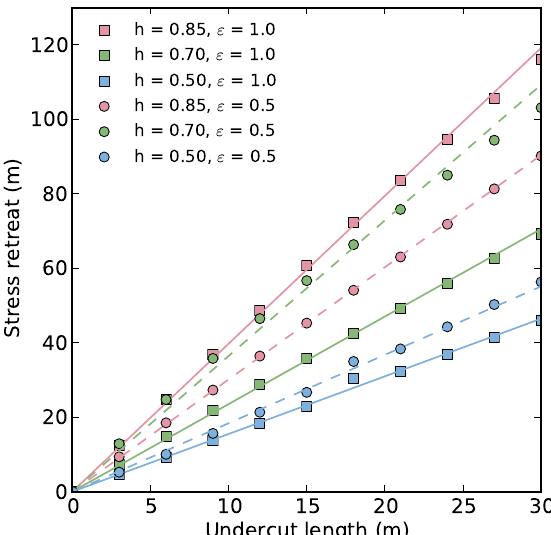
Fig. 3. Stress retreat as a function of undercut length for a variety of scenarios involving different water depths h and dry calving lengths ε . In all cases the relationship is very close to linear. The slope of the linear fit is ω , the wet calving